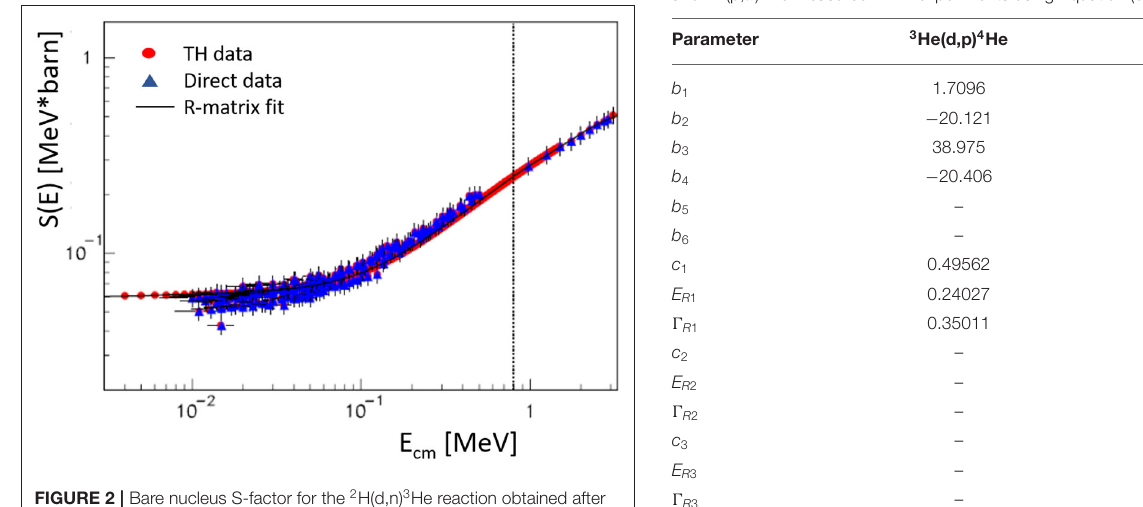
FIGURE 2 | Bare nucleus S-factor for the 2 H(d,n) 3 He reaction obtained after putting together direct data (blue filled triangles) and with the THM ones (red filled circles) taken from Tumino et al. (2014). The solid line is the R-matrix fit to direct and indirect sets, as in section 3.1. The resulting parameters of the equivalent fit (polynomial plus Breit-Wigner) are listed in Table 1 . Energy range of interest for BBN is marked by the vertical dotted line. The figure is adapted from Pizzone et al. (2014).